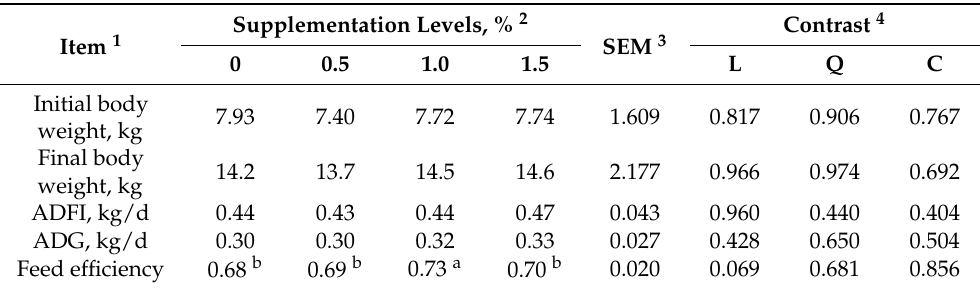
Table 4. Effects of microbial-additive supplementation on the growth performances of weaning pigs fed for 21 d.